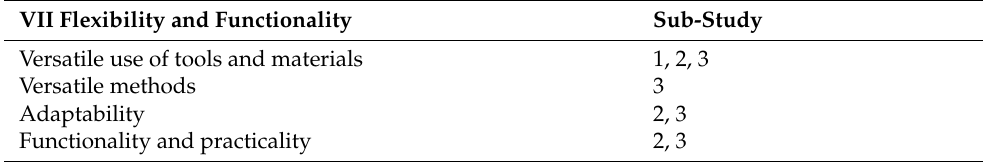
Table 5. Characteristics related to flexibility and functionality confirmed or emerged in